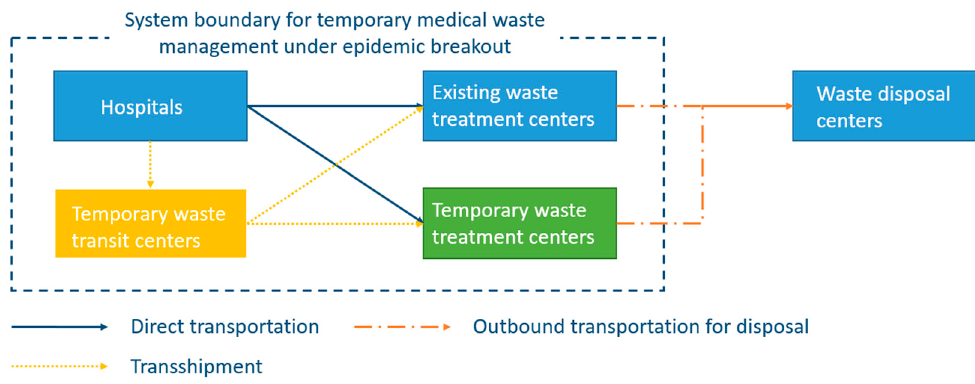
Figure 1. Reverse logistics network for e ff ective management of medical waste in epidemic outbreak.